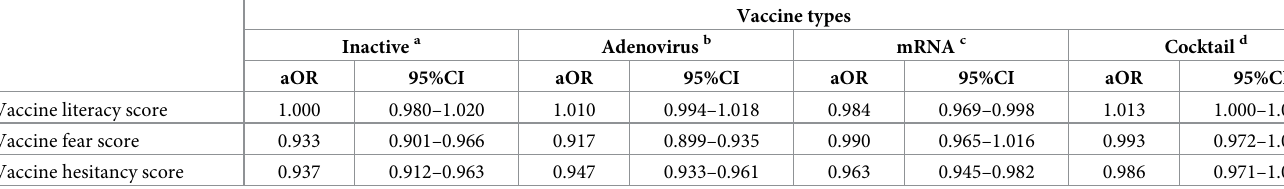
Table 3. Effect of literacy, fear and hesitancy scores on vaccine acceptance by preference